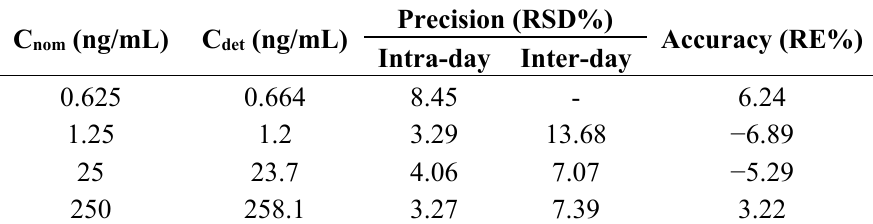
Table 1. Accuracy and precision results for analysis of DHC in rat plasma (3 days, six replicates per